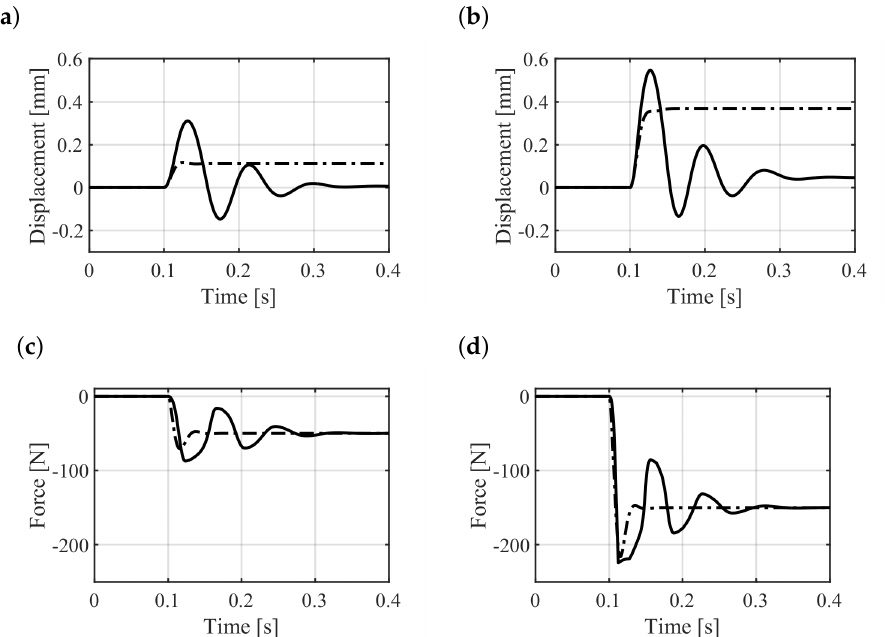
Figure 11. Response of the system with hysteretic (solid) and linearized (dash-dotted) rotor material to external force steps: displacement of the flywheel at the location of the radial AMBs for the 100-N ( a ) and the 300-N ( b ) step amplitude; force provided by each AMB for the 100-N ( c ) and the 300-N ( d ) step amplitude.